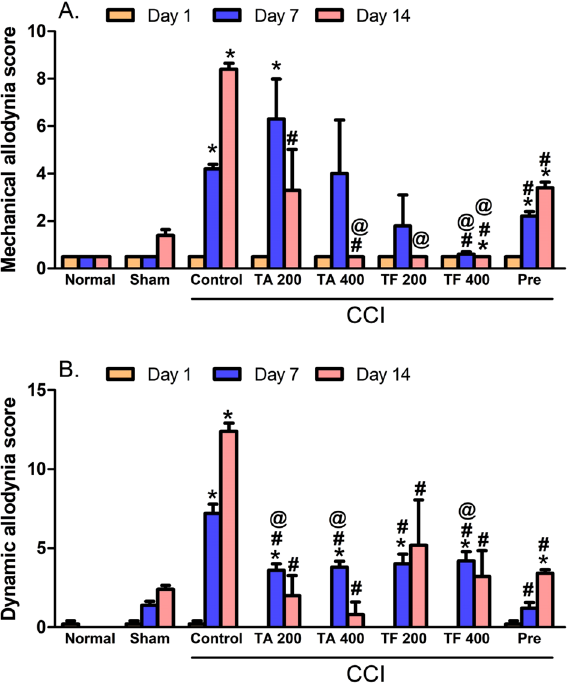
Figure 5. Effect of 200 and 400 mg/kg of T. algerensis ( TA) and T. fontanesii (TF) extracts on ( A ): mechanical hyperalgesia score expressed as paw withdrawal and evaluated using the pin prick assay or ( B ): mechanical dynamic allodynia score (number of withdrawals) as evaluated in the neuropathic pain rats using the paint brush test. In response to the tip of the bent gauge needle, paw withdrawal duration in seconds (ranges from 0.5 s for the short normal response to a 20 s cut-off time), or the number of withdrawals (between 0 and 15) in a total of 15 experiments in response to a paint brush-induced stimulus were recorded and expressed as mean ± SE (n = 6). Statistical analysis was performed using RM-ANOVA, followed by Tukey post hoc test. The different symbols indicate the significance differences at p < 0.05 when compared with sham group (*), CCI group (#), and pregabalin group (Pre, @ ) at the different time points as indicated in the materials and methods